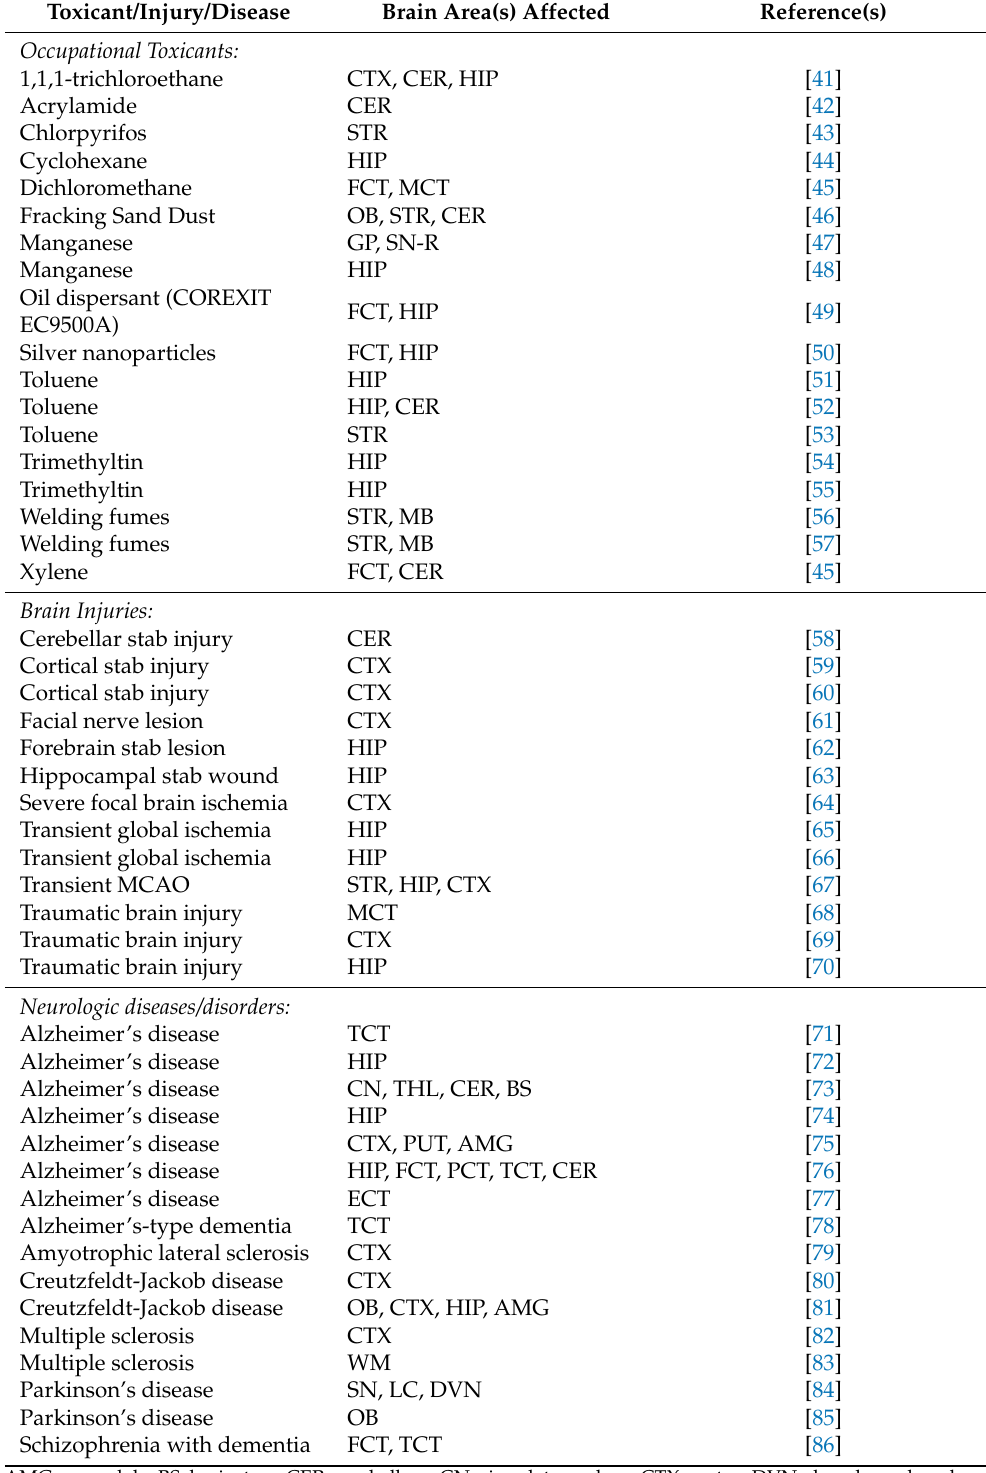
Table 1. Astroglial activation associated with occupational toxicants, brain injuries, and neurologi- cal